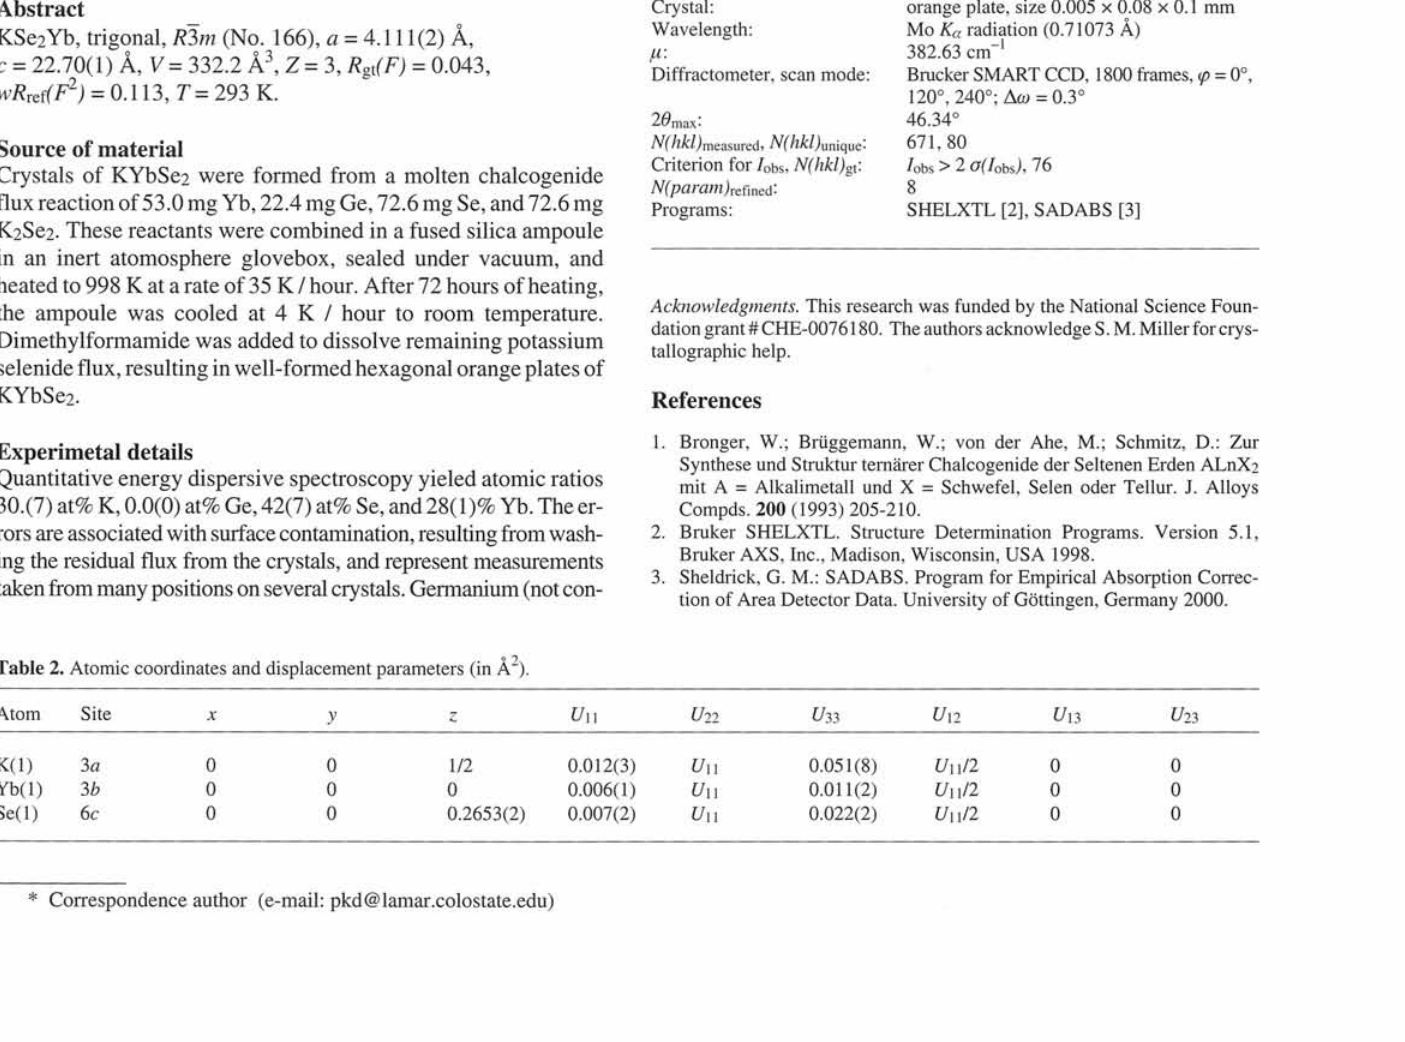
Table 1. Data collection and handling.